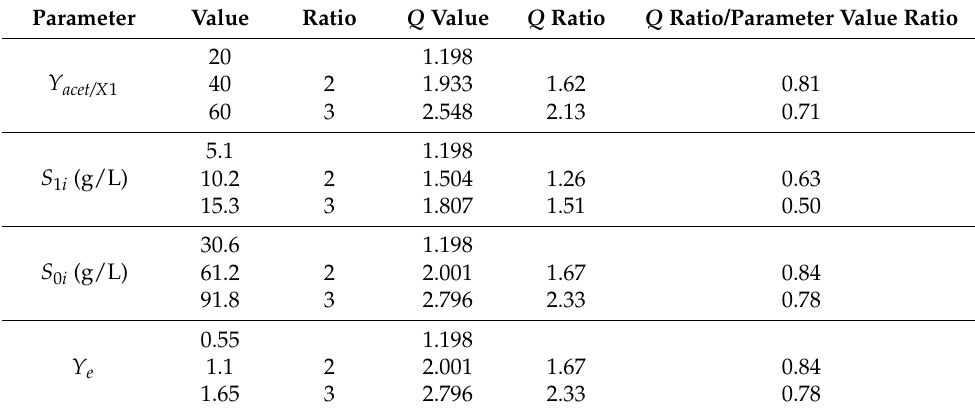
Table 2. Effect of the increment of the value of some parameters of the anaerobic digestion model on the value of biomethane production ( Q